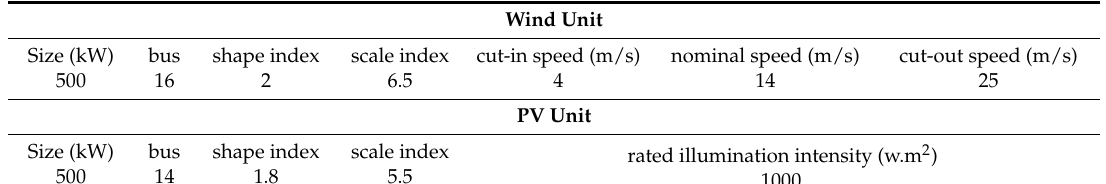
Figure 3 . The 33-bus distribution system.